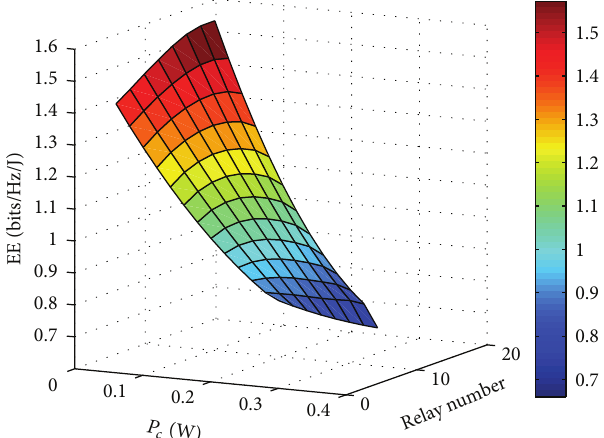
Figure 8: Energy efficiency versus different numbers of relays with = 𝑤 = 1 . 𝑤 1 2